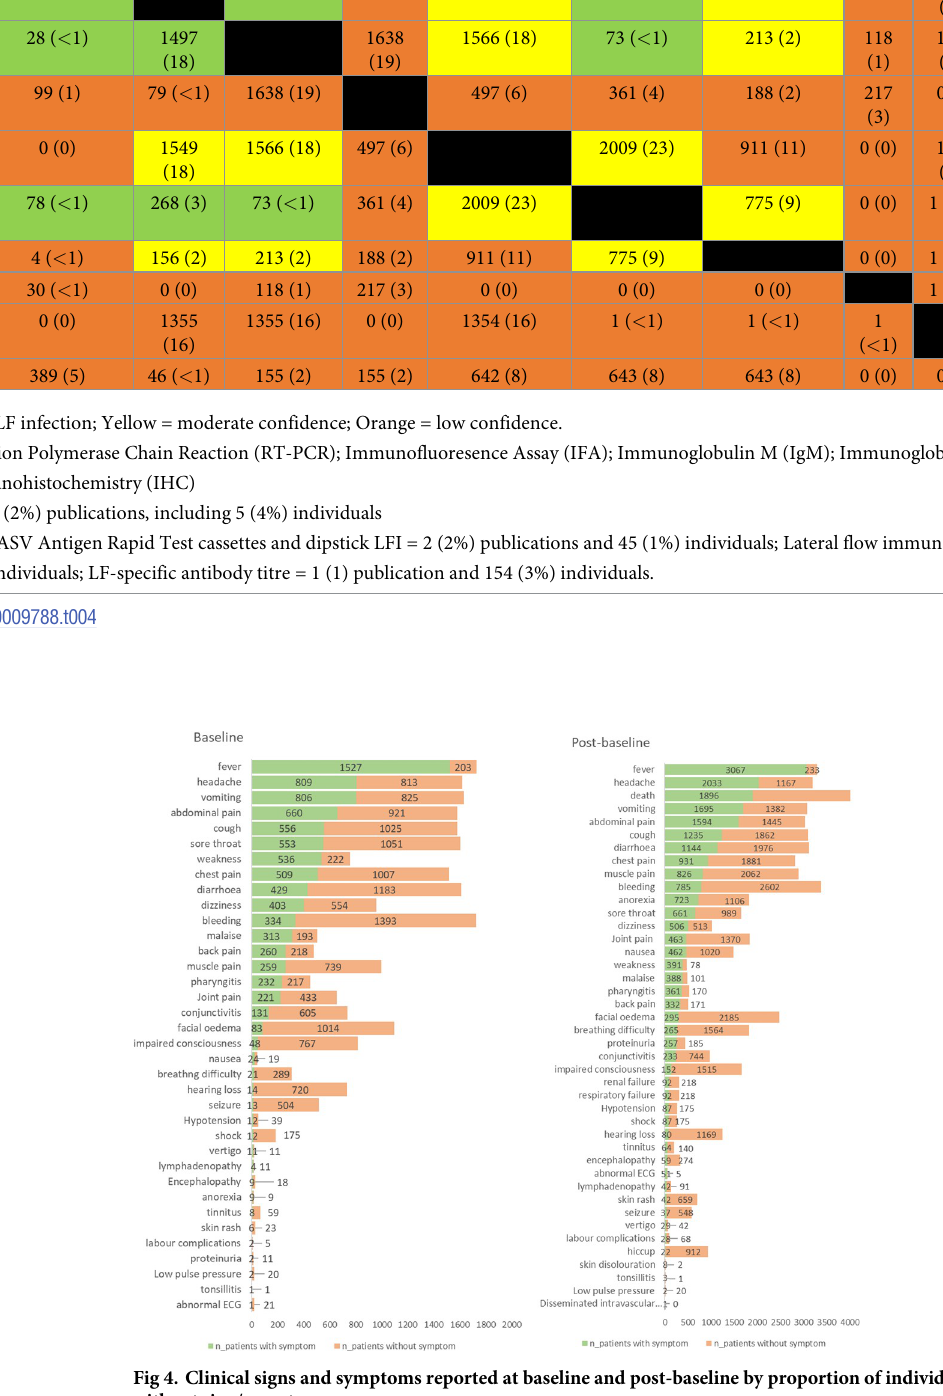
Table 4. Laboratory Diagnostics—Single and combined testing methods by number of individuals tested.